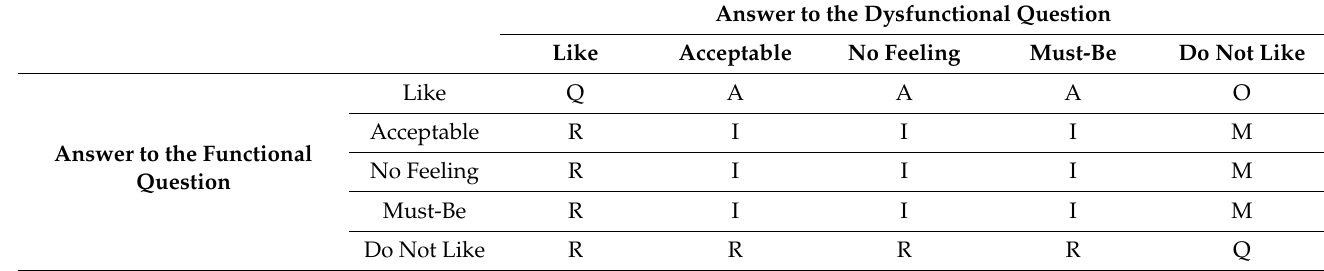
Table 2. Kano model for evaluation of consumer requirements